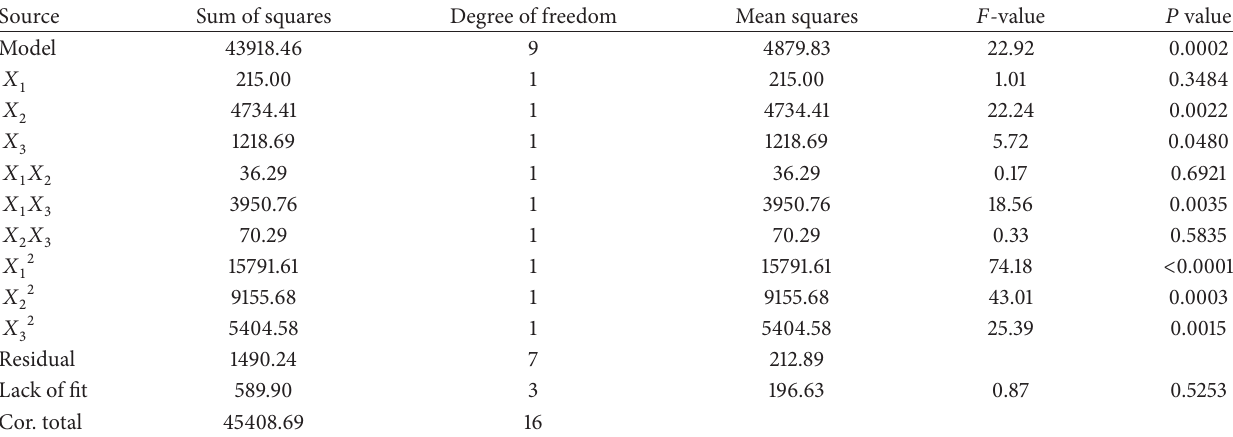
Table 4: Analysis of variance (ANOVA) for the regression